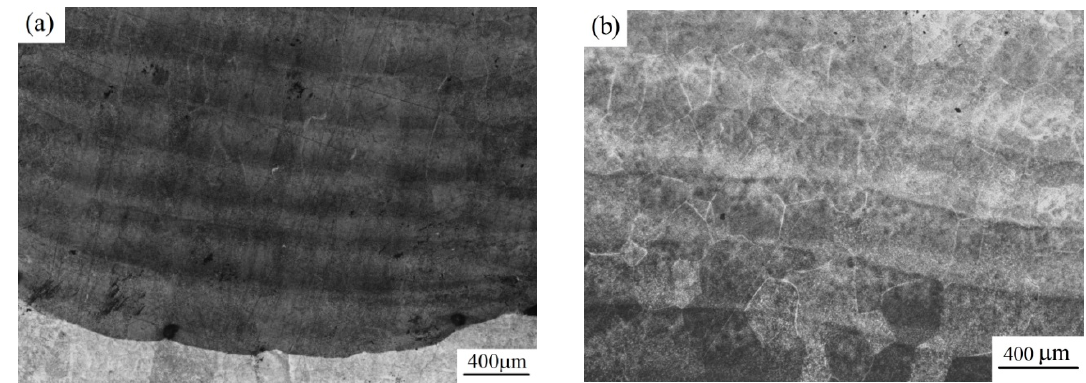
Figure 5. Layers of weld metal on the detail No. 5: ( a ) On the border with the substrate (the light area at the bottom of the image is the substrate); ( b ) In the main part of the paraboloid. All the studied samples have a microstructure typical of the hardened state of two-phase titanium alloys: α -phase precipitates along the primary β -phase grain boundaries, needle-like α -phase precipitates in the grain body with thin β -phase interlayers between them (Figure 6). The so-called “basket weave” structure is clearly distinguished in some fields of view.